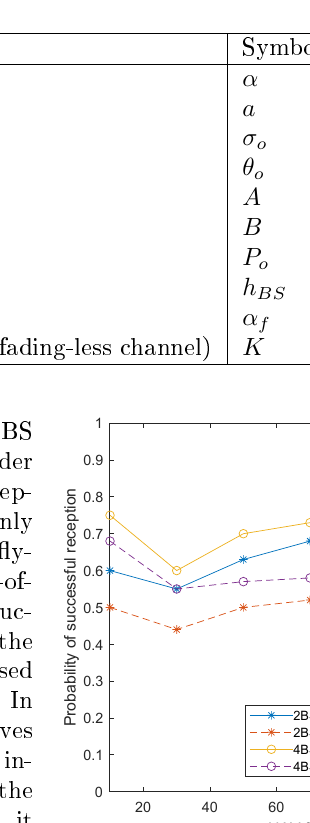
Tab. 1: Network model parameters